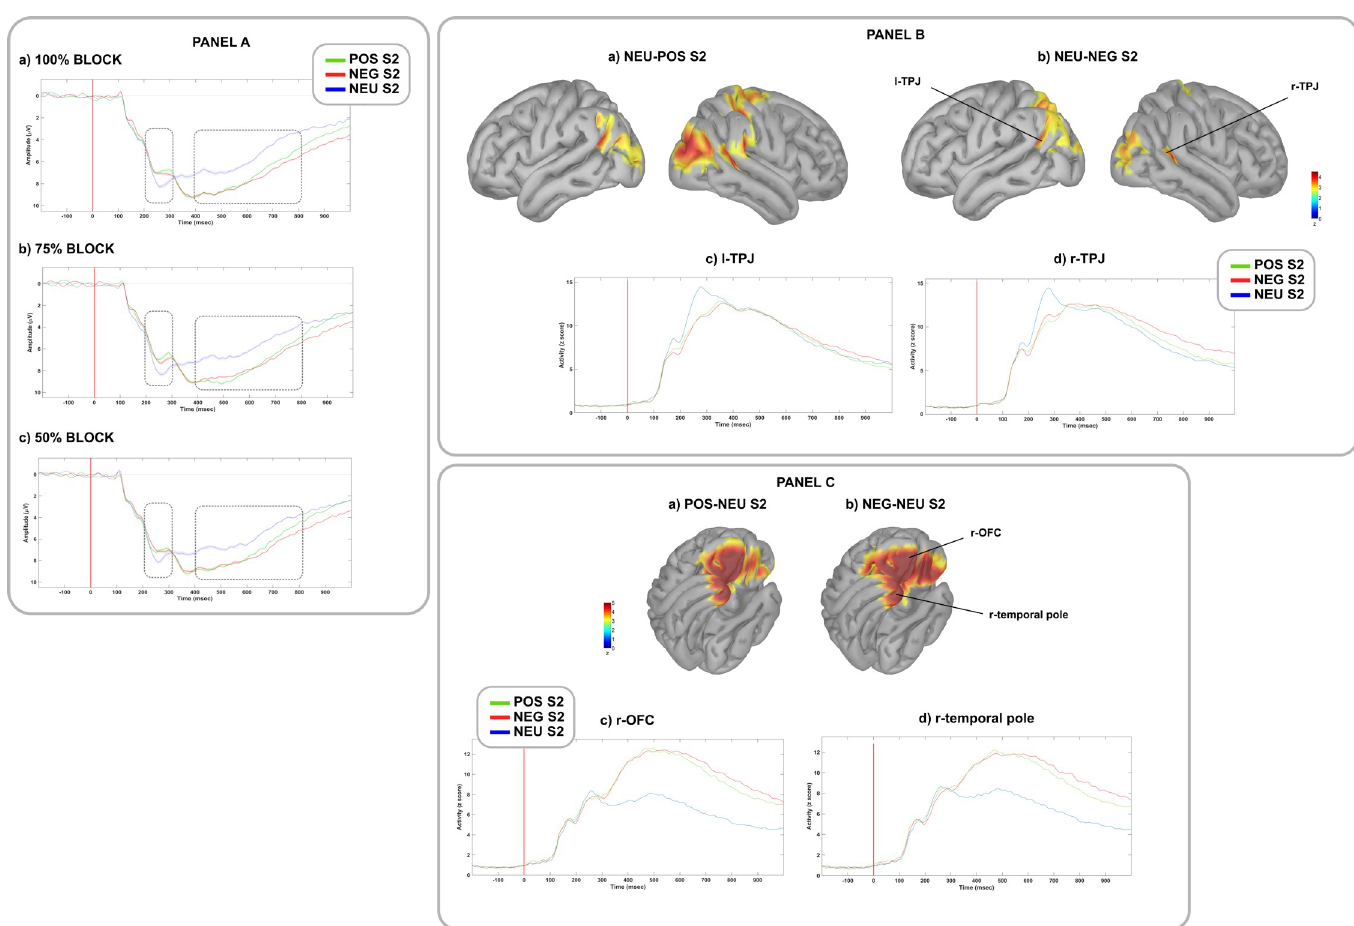
Fig 2. Modulation of ERPs and brain sources during prediction updating stage. PANEL A: Grand average ERP waveforms following negative (red lines), positive (green lines), and neutral (blue lines) pictures (S2) in the (a) 100% , (b) 75% , and (c) 50% blocks. Waveforms are plotted from a parietal cluster of electrodes (E60, E61, E62, E67, E71, E72, E75, E76, E77, E78, E85). Shaded areas denote standard error. P2 was computed between 200 and 300 msec, and LPP between 400 and 800 msec from S2 onset (time 0). PANEL B: On the top, cortical maps reconstruction of the (a) NEU-POS and (b) NEU-NEG differences in brain activations in the P2 temporal window (200–300 ms). On the bottom, time course of (c) l-TPJ, and (d) r-TPJ activations to positive (green lines), negative (red lines), and neutral (blue lines) pictures, regardless of blocks. l-TPJ = left temporoparietal junction, r-TPJ = right temporoparietal junction. PANEL C: On the top, cortical maps reconstruction of the (a) POS-NEU and (b) NEG-NEU differences in brain activations in the total LPP temporal window (400–800 ms). On the bottom, time course of (c) r- OFC and (d) r-temporal pole activations to positive (green lines), negative (red lines), and neutral (blue lines) pictures, regardless of blocks. r-OFC = right orbitofrontal cortex.